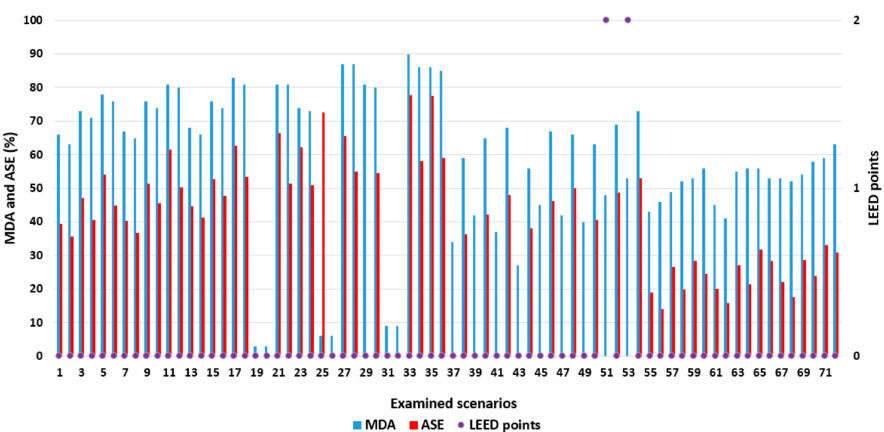
Figure 9. Selection of the sawtooth type for the final step of the optimisation methodology (LEED points: 2, ASE 0%, MDA 53%).